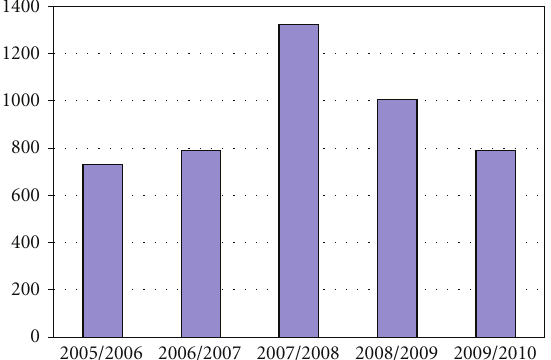
Figure 1: Annual referral rate over 5 years period to LOAP service. The decrease in referrals in 2008/2009 and 2009/2010 period reflects the restructuring of medical wards on the 4 hospital sites in Newcastle, as described in the text, and also the introduction of the Mental Capacity Act (discussed in greater detail in the